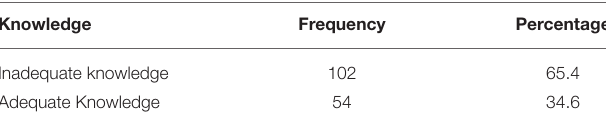
TABLE 3 | Level of knowledge of nurses about the prevention and control of TB n =